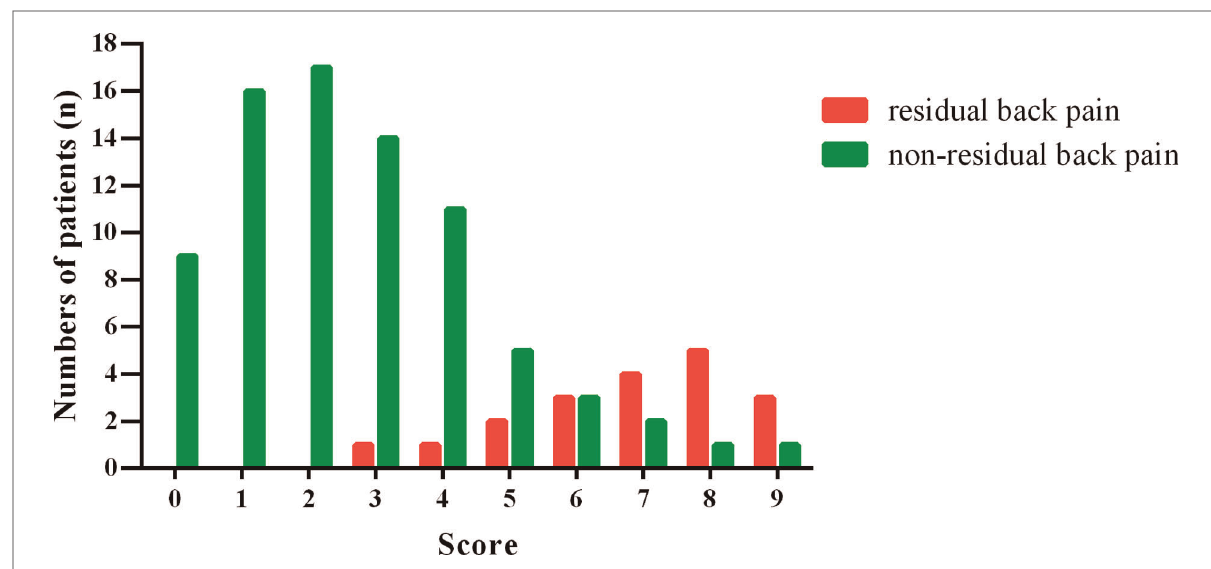
FIGURE 2 Histogram distribution of residual back pain group and non-residual back pain group for each score of the scoring system.